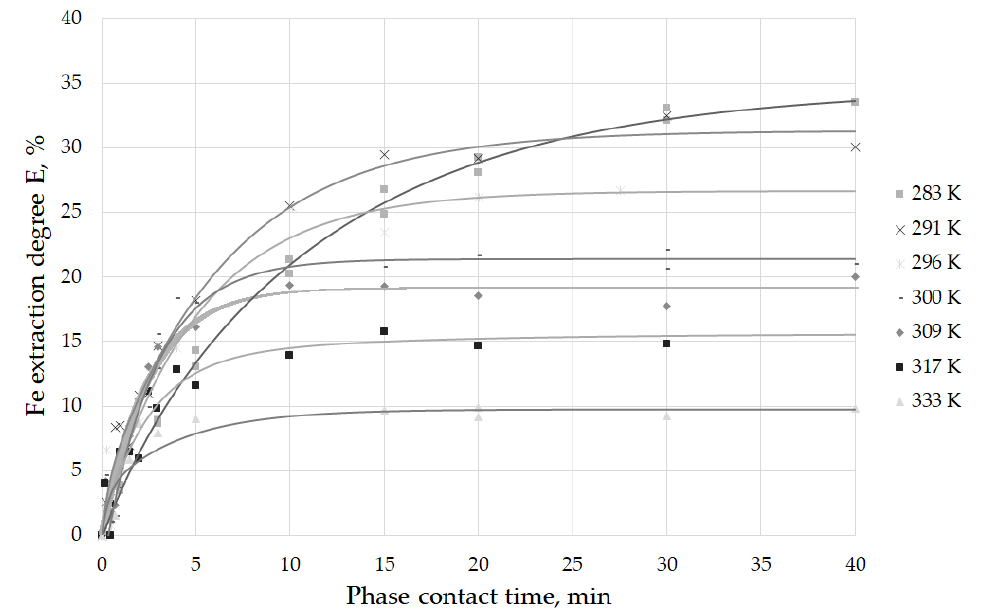
Figure 6. The dependences of the iron (III) extraction degree on the phase contact time at a different temperature and a stirring rate of 600 RPM.